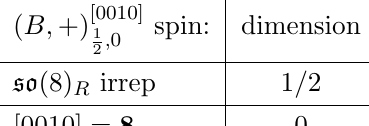
Table 10 . All possible conformal primaries in S 2 (cid:2) S 3 corresponding to the ( B; +) [0010] formal